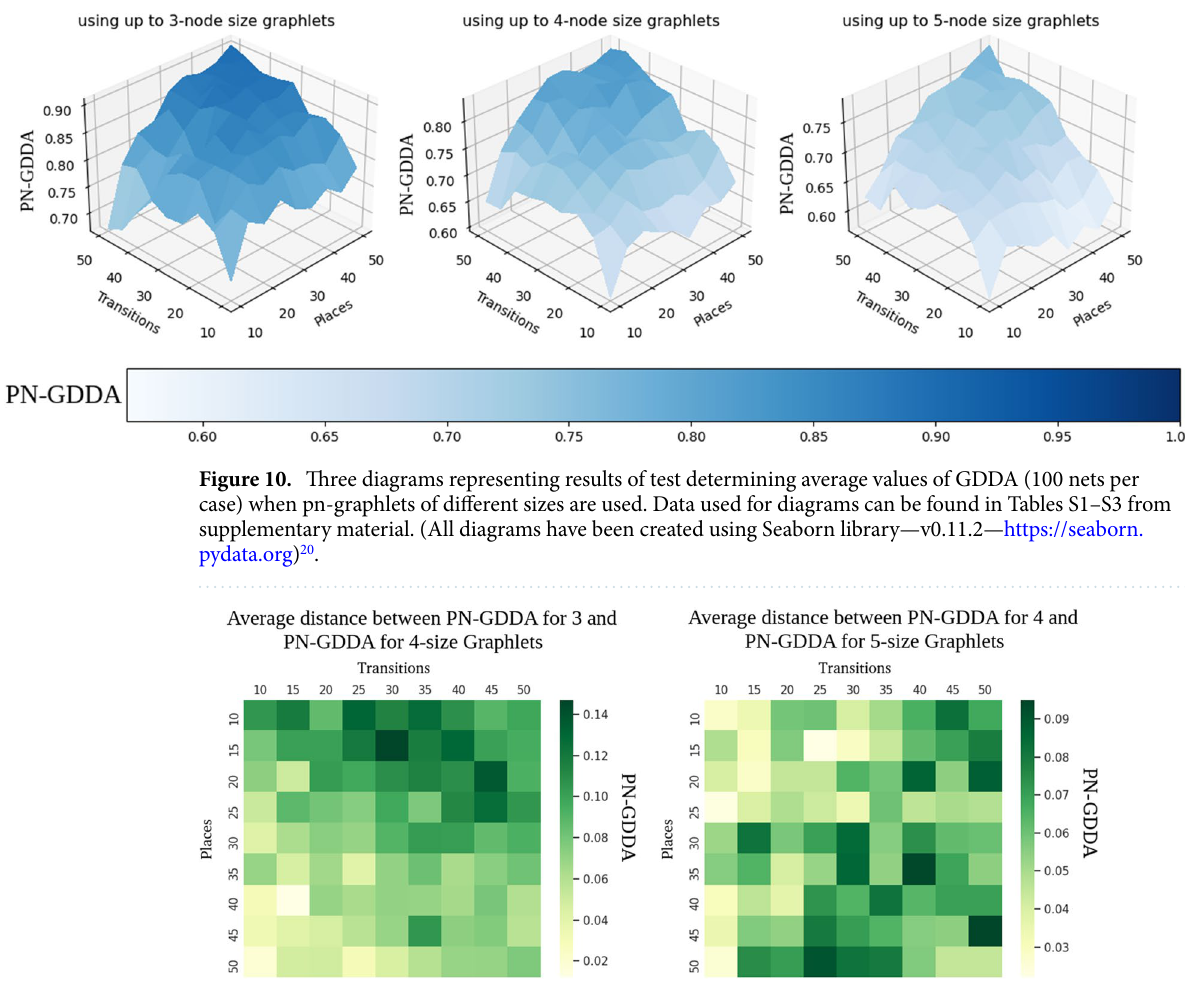
Figure 11. Average similarity level decrese after switching between 3-node and 4-node pn-graphlets (left heatmap), and between 4-node to 5-node pn-graphets (right heatmap) 20